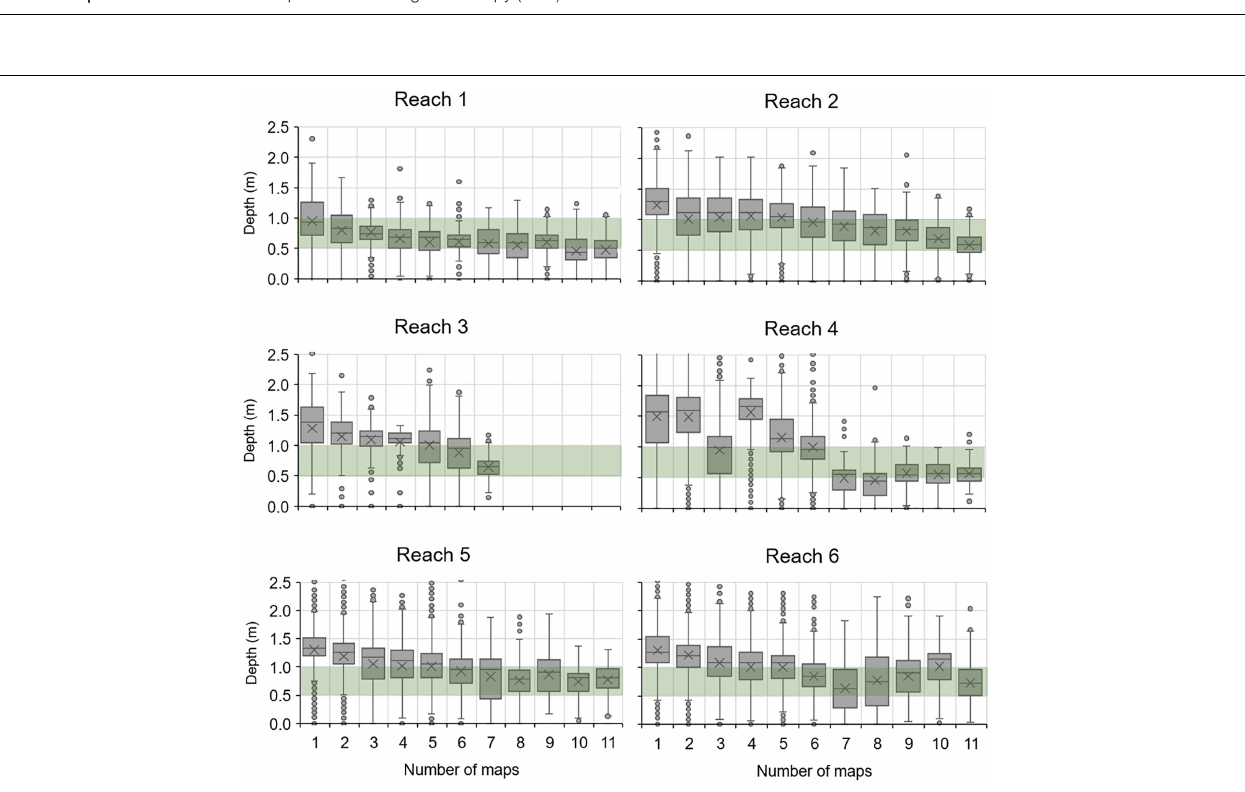
FIGURE 6 | Box plots for depths within polygons of seagrass that persisted across differing numbers of maps. Green bar, 0.5–1.0 m depths below mean water level (MWL); X, mean depth; horizontal line, median depth; box, interquartile range; whiskers, 5th and 95th percentiles; points, values beyond the 5th and 95th percentiles.